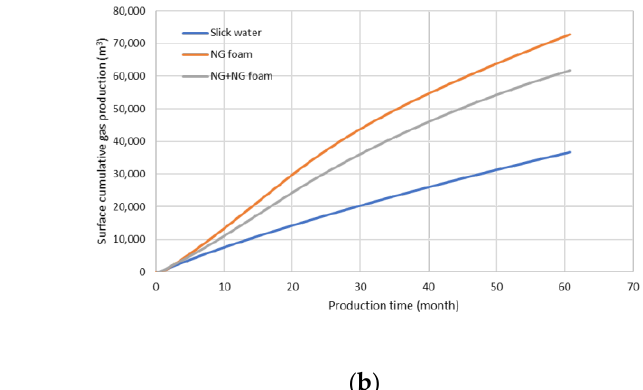
Figure 16. Pore pressure distribution on the horizontal plane through the wellbore at the end of the production period. ( a ) Case using slick water, ( b ) Case using NG foam, ( c ) Case using hybrid NG and NG foam.